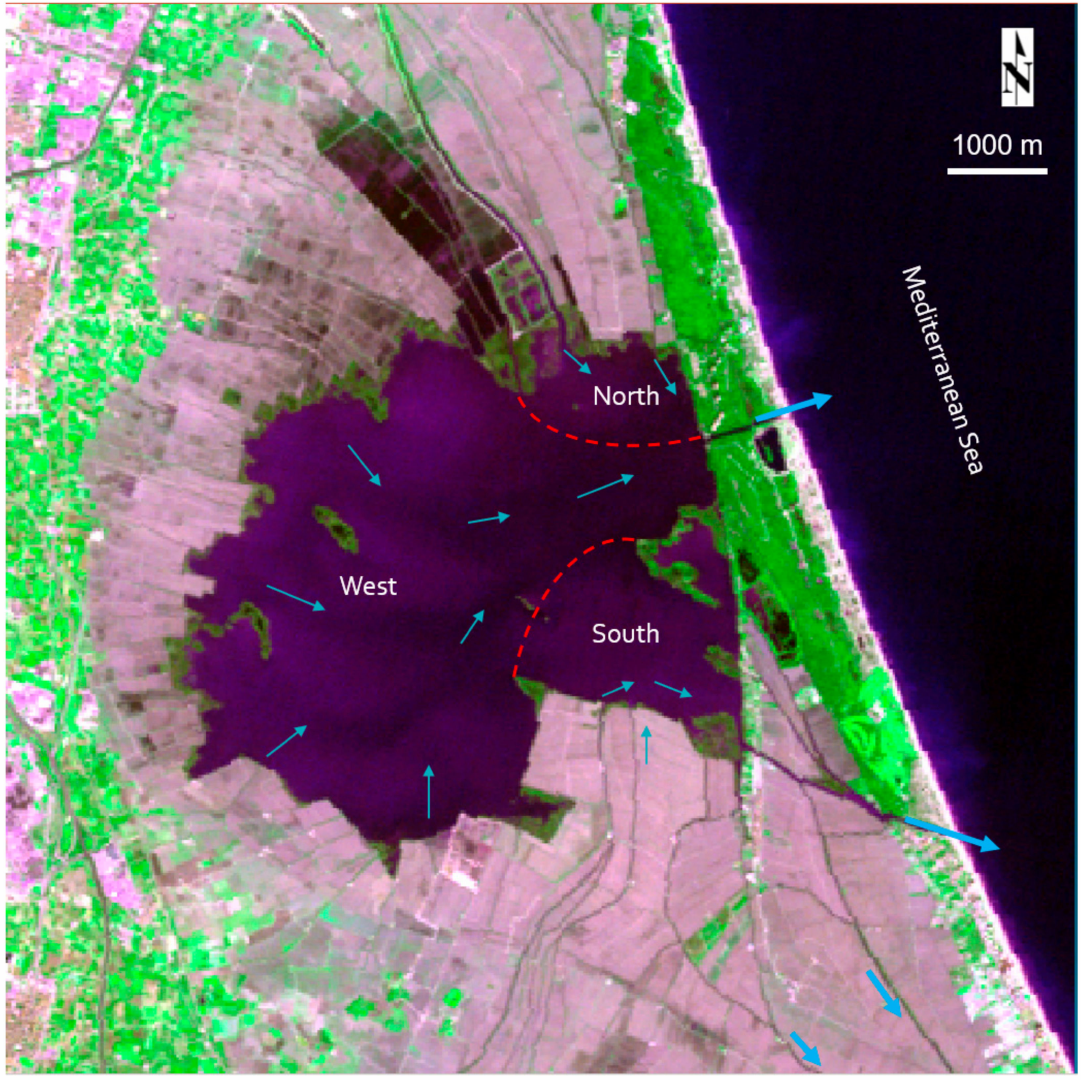
Figure 6. Distribution in zones and water circulation in the Albufera elaborated from the bathymetry of the lagoon and the observations in the lagoon itself. Landsat-5 base image in false natural color from 14 March 2010: Dark areas indicate greater depth (over 1.2 m) and light areas less depth (over 0.6